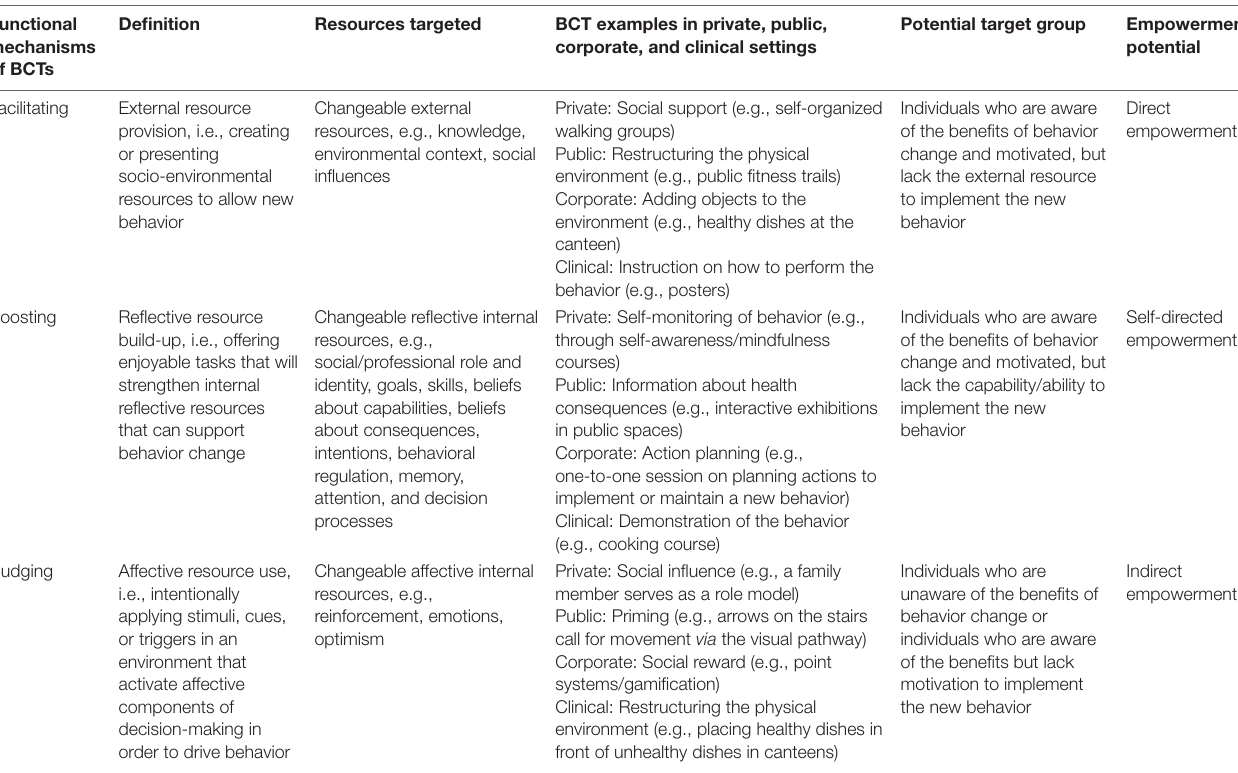
TABLE 2 | Summary of the model and application guide. Functional